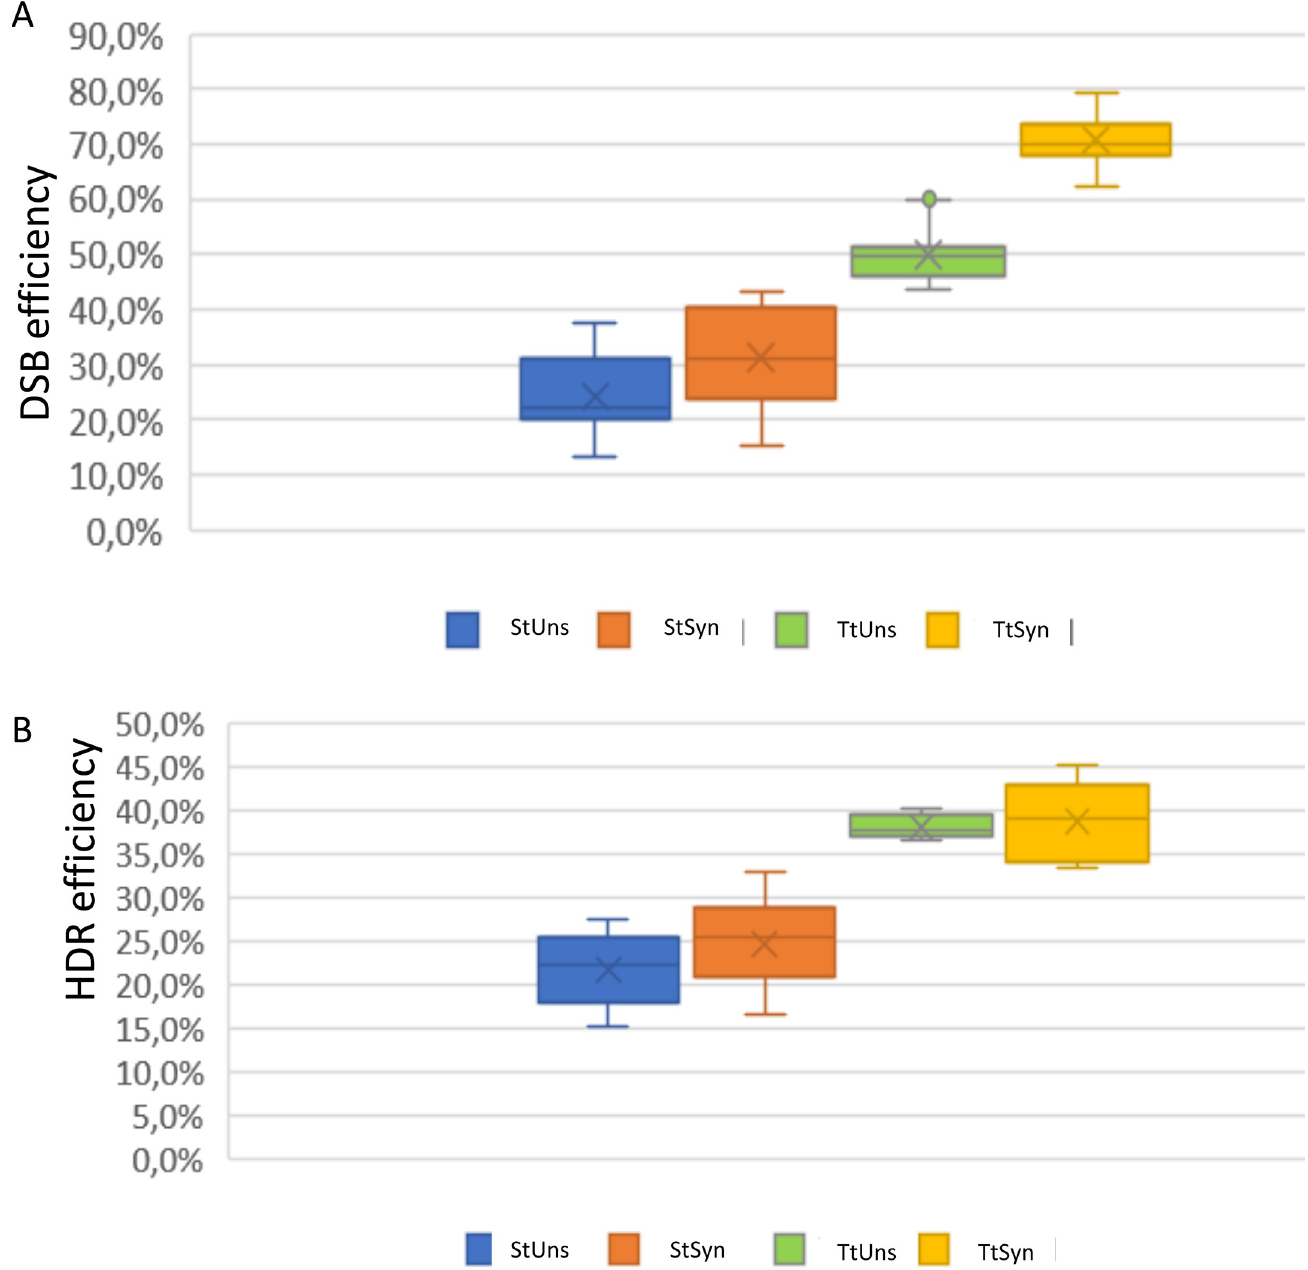
Fig 6. DSB efficiency (A) Editing efficiency tested on four different conditions. The DSB efficiency increases with triple transfection in synchronized cells (TtSyn). (B) Double cut strategy and donor M, in single and triple transfection, in synchronized and unsynchronized cells. The triple transfection increased HDR efficiency. StUns = Single transfection method, unsynchronized cells; StSyn = Single transfection in synchronized cells; TtUns = Triple transfection method in unsynchronized cells; TtSyn = Triple transfection in synchronized cells.